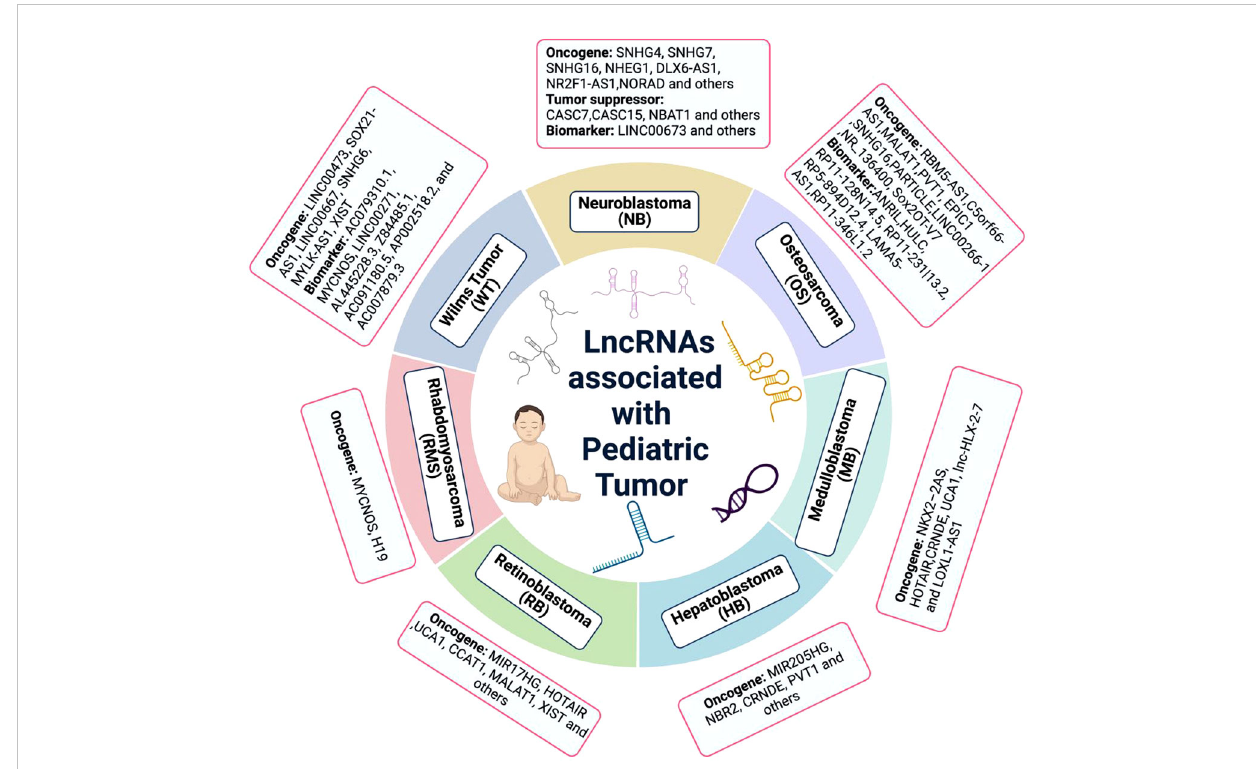
FIGURE 1 The lncRNA associated with pediatric cancer. Many lncRNAs have been discovered to be dysregulated in pediatric cancers. While, the lack of deep understanding of molecular mechanism is the huge obstacle at